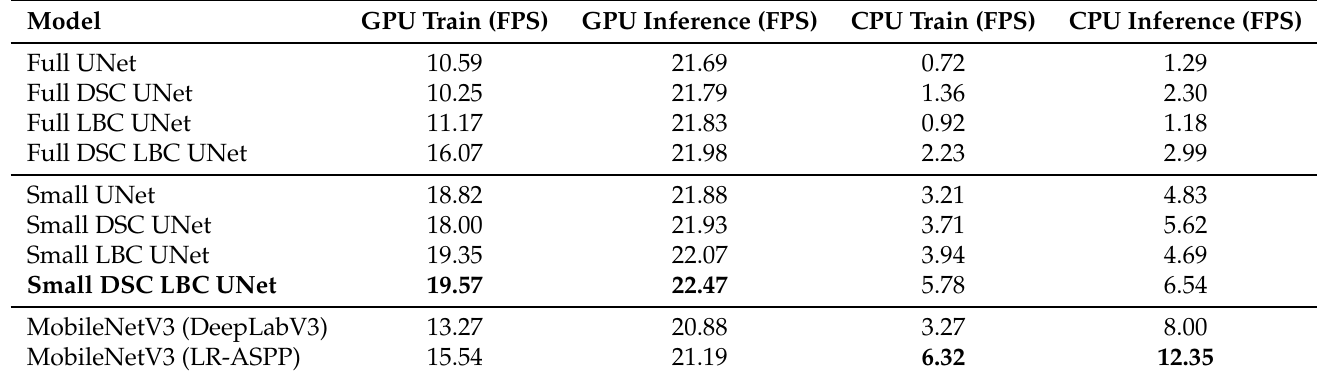
Table 3. Training and inference runtime measured in frames-per-second (FPS) on a Nvidia GeForce GTX 1060 GPU and AMD Ryzen 5 2600 Six-Core CPU. Images of size 320 × 320 × 3 were used during